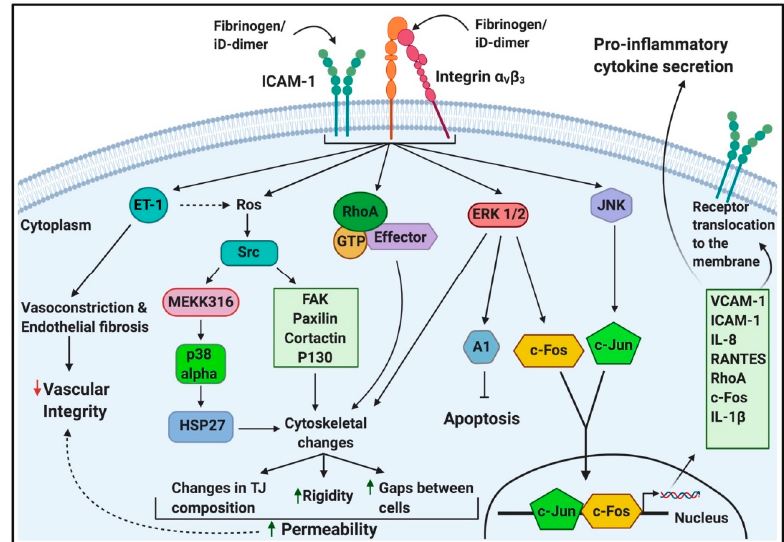
Figure 6. The intracellular signalling of endothelial cells upon ligation of fibrinogen (and iD-dimer): adapted from [70–73,75,100,102]. Abbreviations: ICAM-1, intercellular adhesion molecule-1; RhoA, activated Rho factor protein; iD-dimer, immobilised D-dimer; ROS, reactive oxygen species; Src, sarcoma; MEKK316, endothelial MAP kinases 3 and 6 (MKK-3 and -6); FAK, focal adhesion kinase; p130, retinoblastoma-like protein-2; p38, mitogen-activated protein kinase; HSP27, heat shock protein 27; ERK, extracellular signal-regulated kinase/extracellular receptor kinase; c-Fos, proto-oncogene; JNK, stress-activated protein kinase; c-Jun, protein encoded by the JUN gene; VCAM-1, vascular cell adhesion protein-1; IL-8, interleukin-8; RANTES, regulated upon activation normal T cell expressed and presumably secreted; IL-1 beta, interleukin-1 beta. This image was made with BioRender (https: // biorender.com /